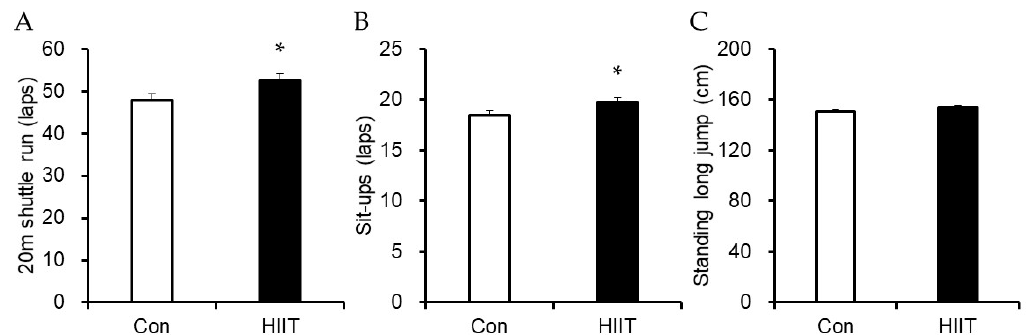
Figure 1. Comparisons of physical fitness via 20-m shuttle run ( A ), sit-ups ( B ), and standing long jumps ( C ), adjusted for pre-test values and age between groups. Values are presented as means ± standard deviation, adjusted for pre-test values and age. * p < 0.05, significant difference between groups.